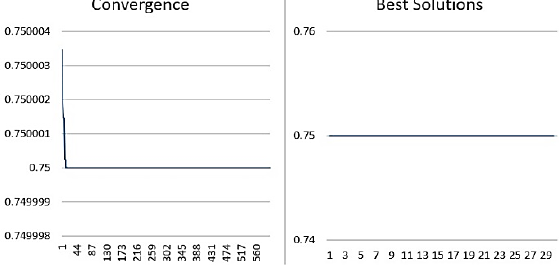
Figure 5. Convergence curve and 30 best solutions for constraint problem